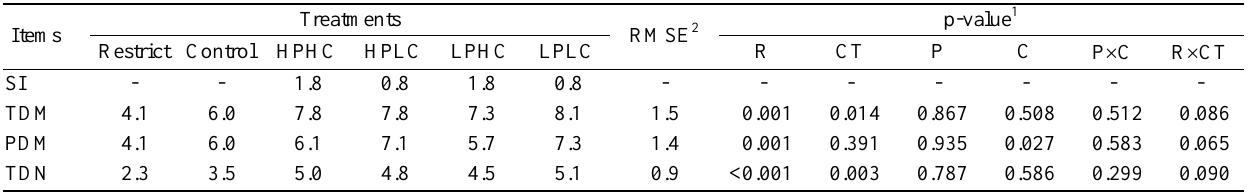
Table 3. Effect of nutritional plan (least square means, kg/d) on intake of supplement (SI), total dry matter (TDM), pasture dry matter (PDM) and of total digestible nutrients